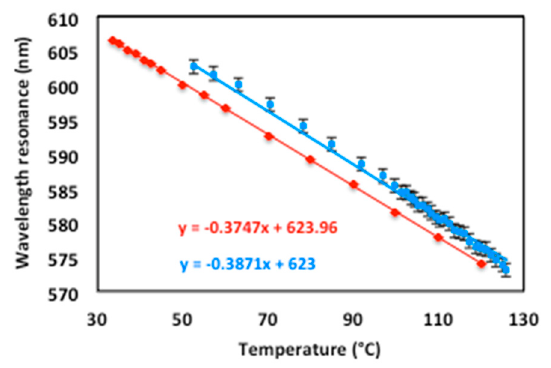
Figure 10. Resonance wavelength 𝜆 𝑅 (cid:4666) 𝑇 (cid:4667) versus temperature—experimental data in blue and theoretical in red.